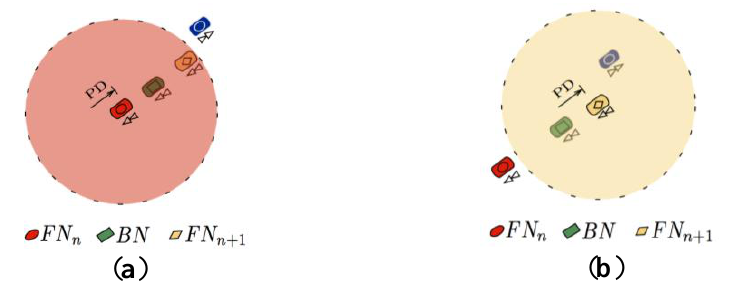
Figure 3. Example of the Light Acknowledgement Mechanism implemented in